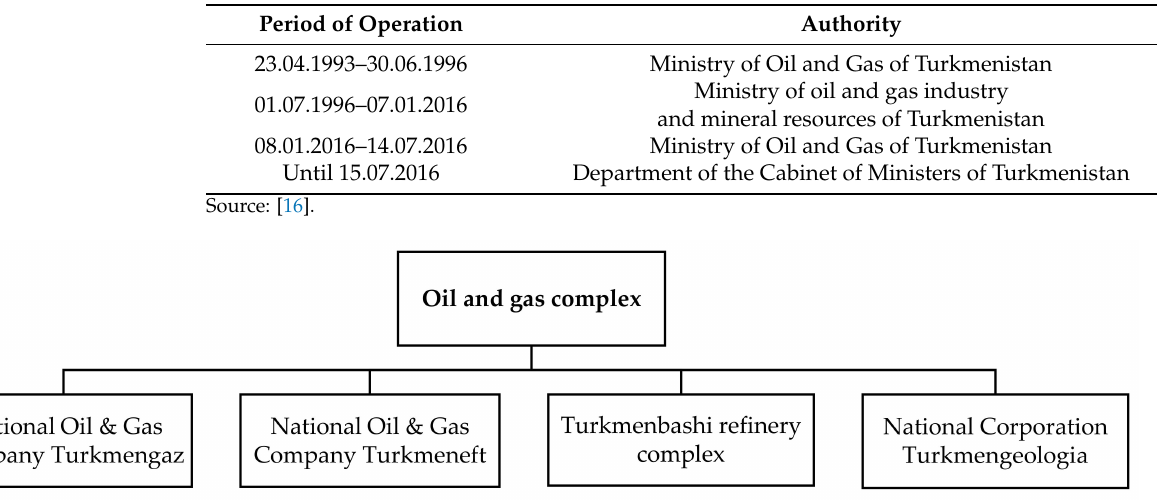
Figure 1. The structure of the oil and gas complex of Turkmenistan. Source: